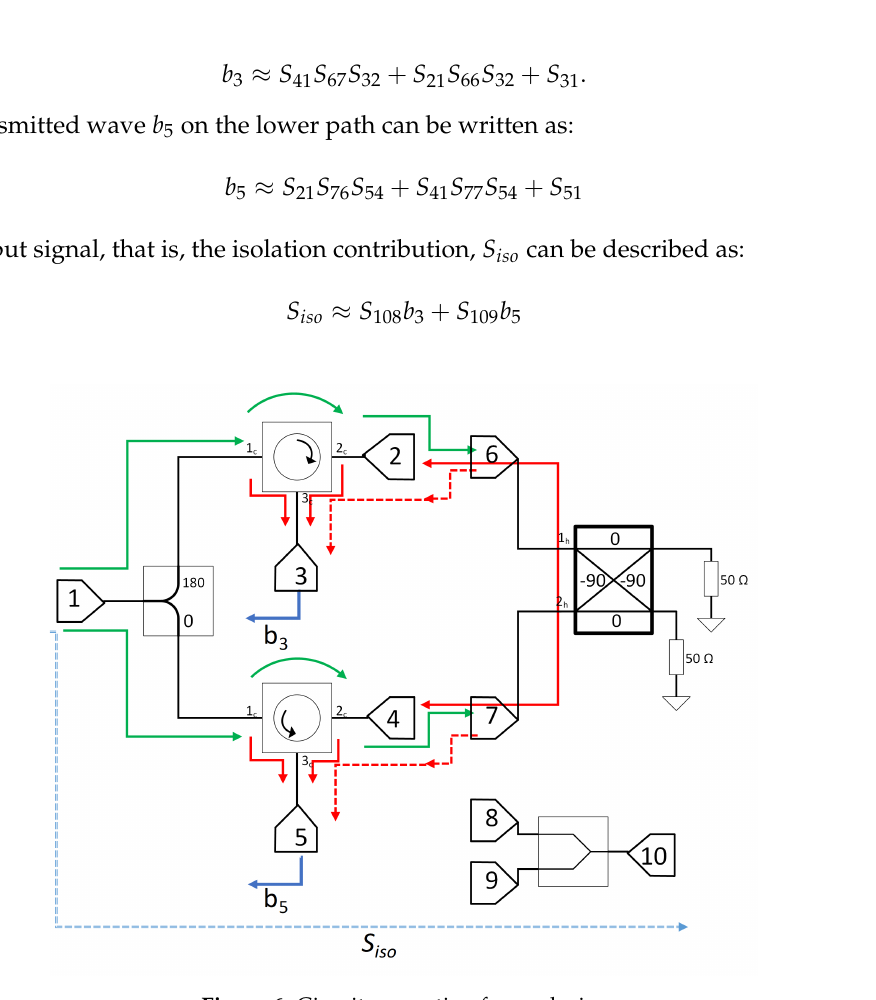
Figure 6. Circuit separation for